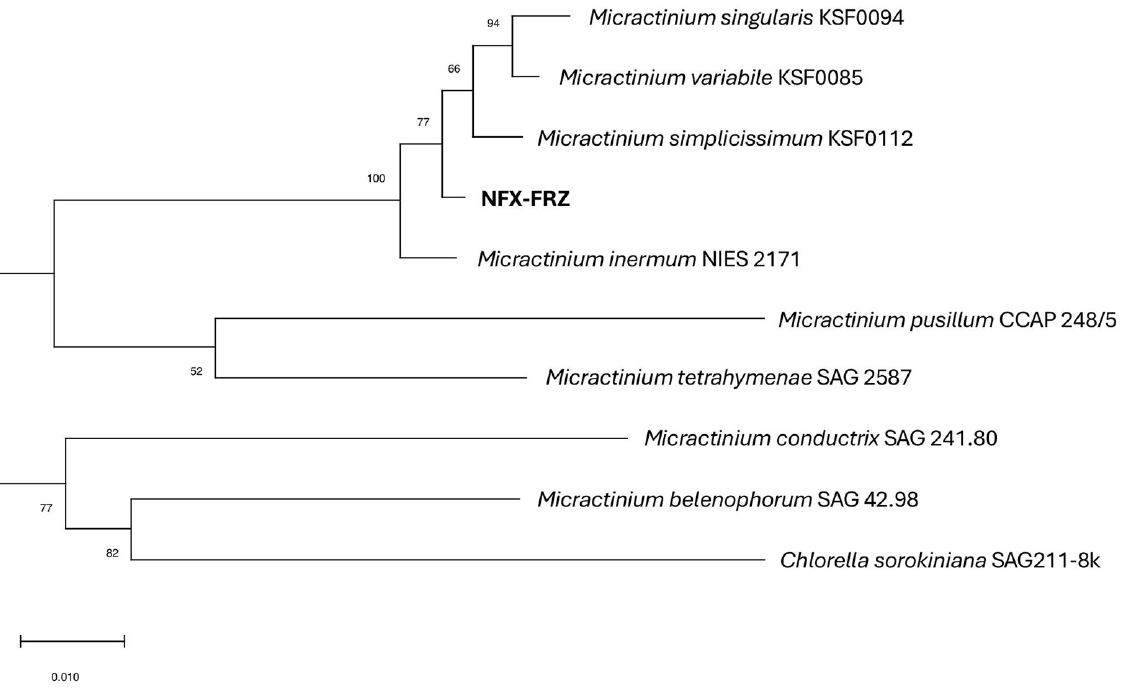
Figure 2. Phylogram based on Micractinium 18S-ITS1-5.8S-ITS2 regions (2477 bp). The evolutionary history was inferred by using the maximum likelihood method and Tamura-Nei model. The tree with the highest log likelihood ( − 5991.31) is shown. The percentage of trees in which the associated taxa clustered together is shown next to the branches. A discrete gamma distribution was used to model evolutionary rate differences among sites (5 categories (+G, parameter = 0.2992)). The rate variation model allowed for some sites to be evolutionarily invariable ([+I], 62.93% sites). The tree is drawn to scale, with branch lengths measured in the number of substitutions per site.